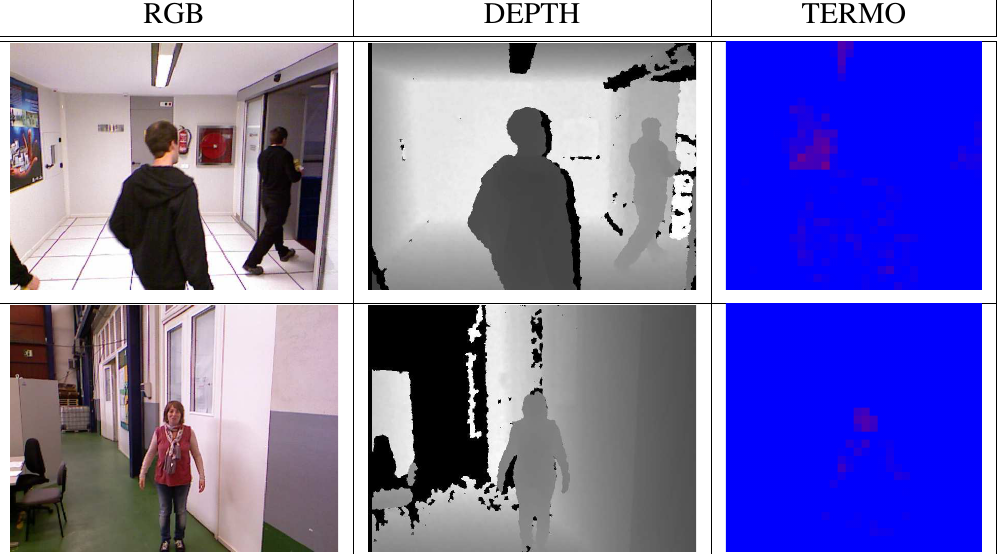
Figure 6. Positive examples in the three data sources (intensity, depth, thermal) with people with different sizes and positions. RGB DEPTH